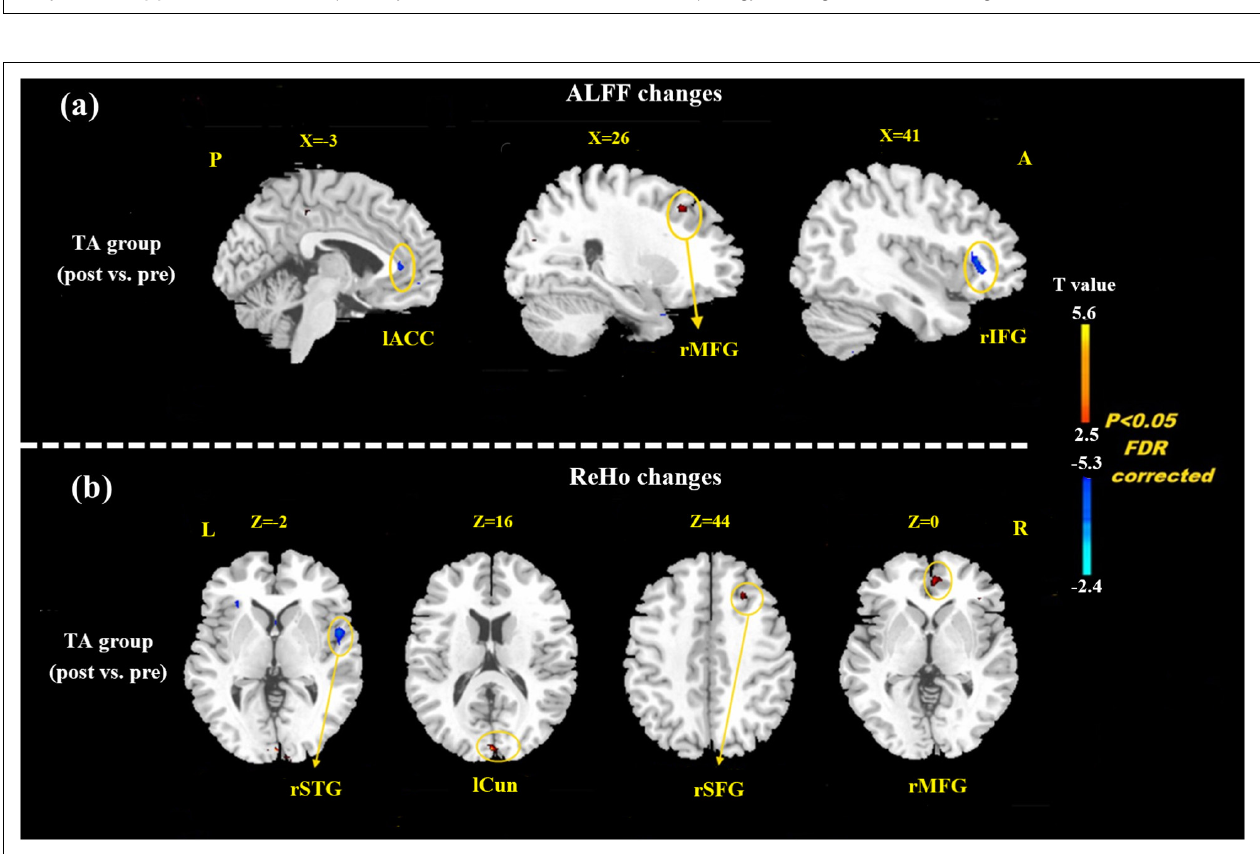
FIGURE 2 | Correlation analysis between ALFF value in MTG and VAS in the MMoA patients ( p < 0.05, FDR corrected). (a) Brain region used for the correlation analysis shown. (b) ALFF in the MTG was positively correlated with VAS. MTG, middle temporal gyrus; R, right; VAS, visual analog scale.